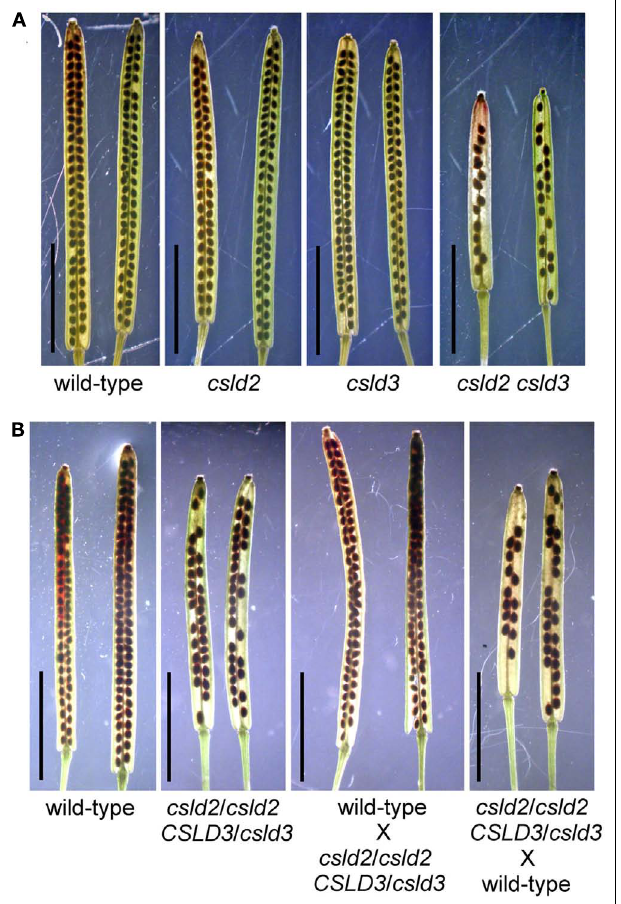
FIGURE 1 | csld2 csld3 double mutants have siliques with fewer seeds. Whole-mount images of the mature siliques cleared with 0.2N NaOH and 1% SDS solution. (A) Siliques from wild-type, csld2 and csld3 single mutants, and the csld2 csld3 double mutant. (B) Siliques from the